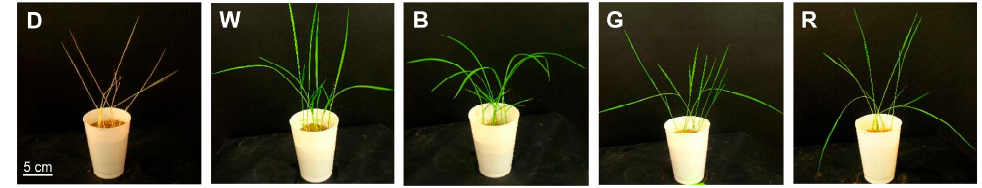
Figure 2. Effects of different wavelengths of LEDs on the growth parameters of rice seedlings. The